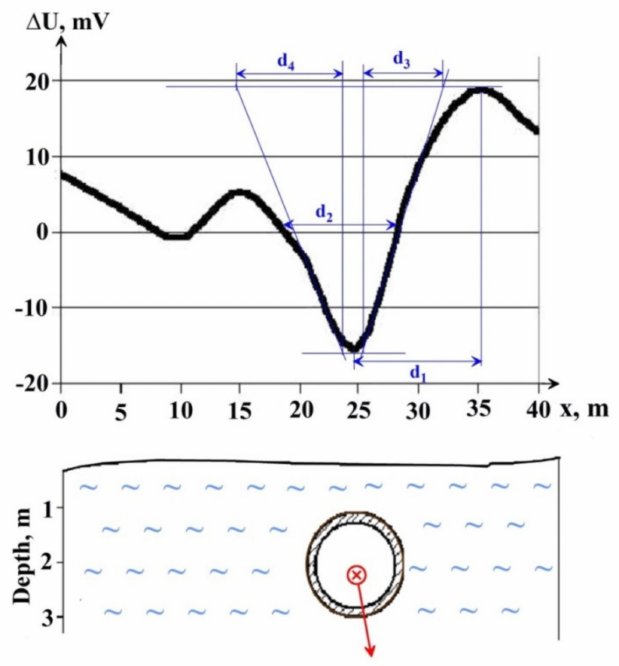
Figure 21. Quantitative examination of the SP anomaly from the buried metallic pipe (southern Russia). Observed SP graph and near-surface section are taken from [33]. The red circle indicates the determined position of the center of HCC, and the red arrow shows the orientation of the self-potential vector.